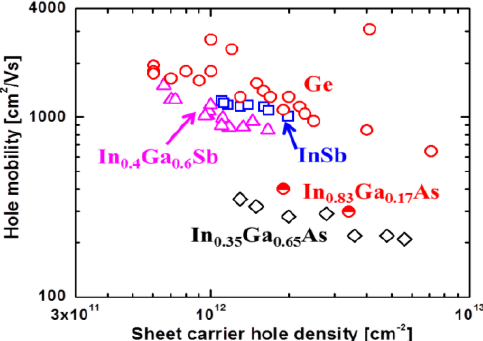
Figure 9. Room temperature hole mobility vs. sheet carrier density in biaxially compressed QWs: InSb [157,158],